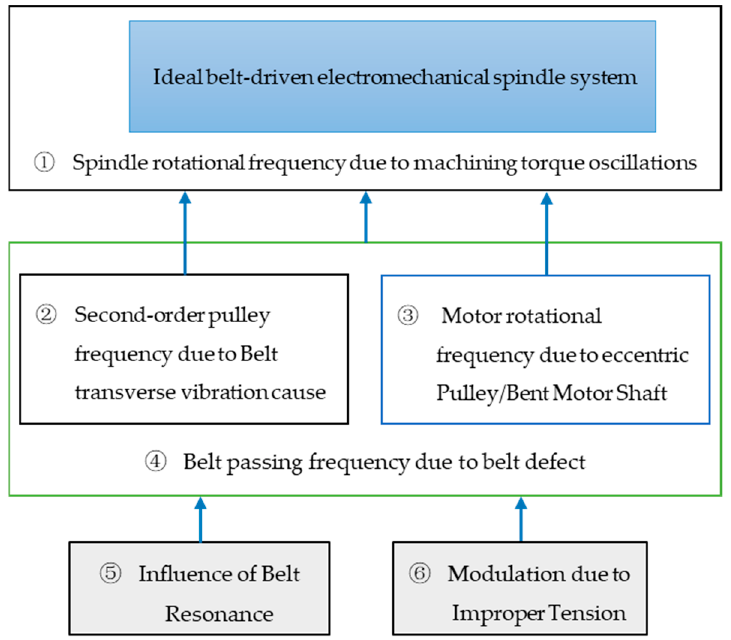
9 of 19 Figure 5. Flowchart for solving dynamic equations using an explicit Runge–Kutta method in MATLAB platform.